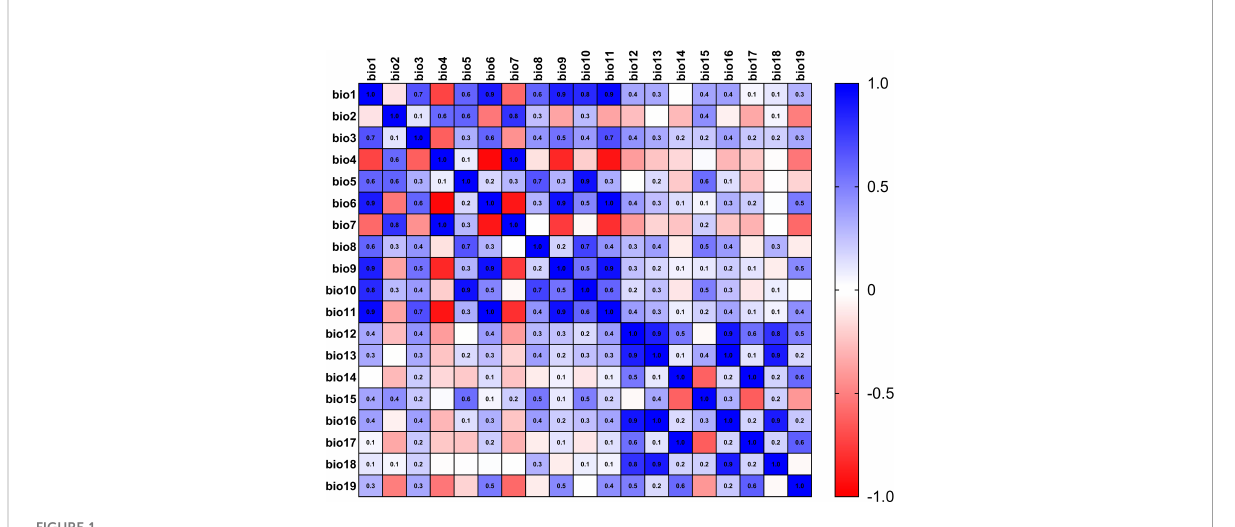
FIGURE 1 Heat map for correlation analysis of environmental factors in L.